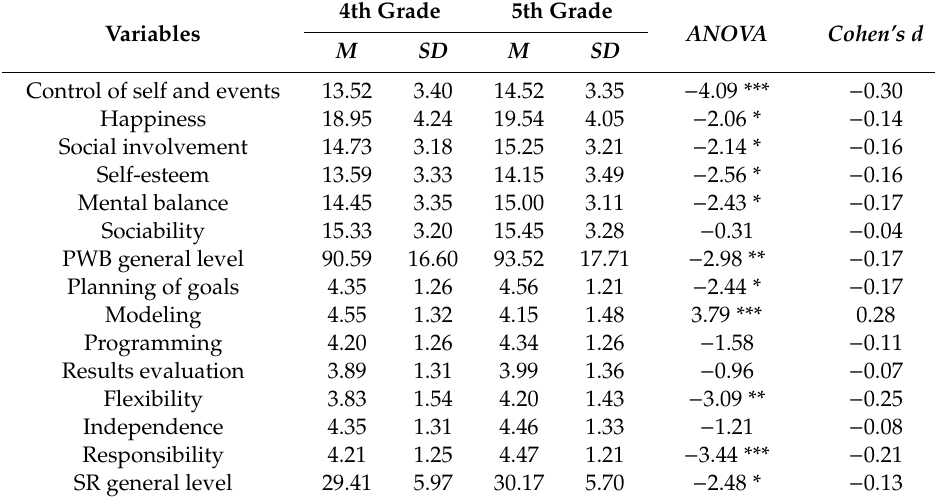
Table 1. Descriptive statistics. PWB: psychological well-being, SR: